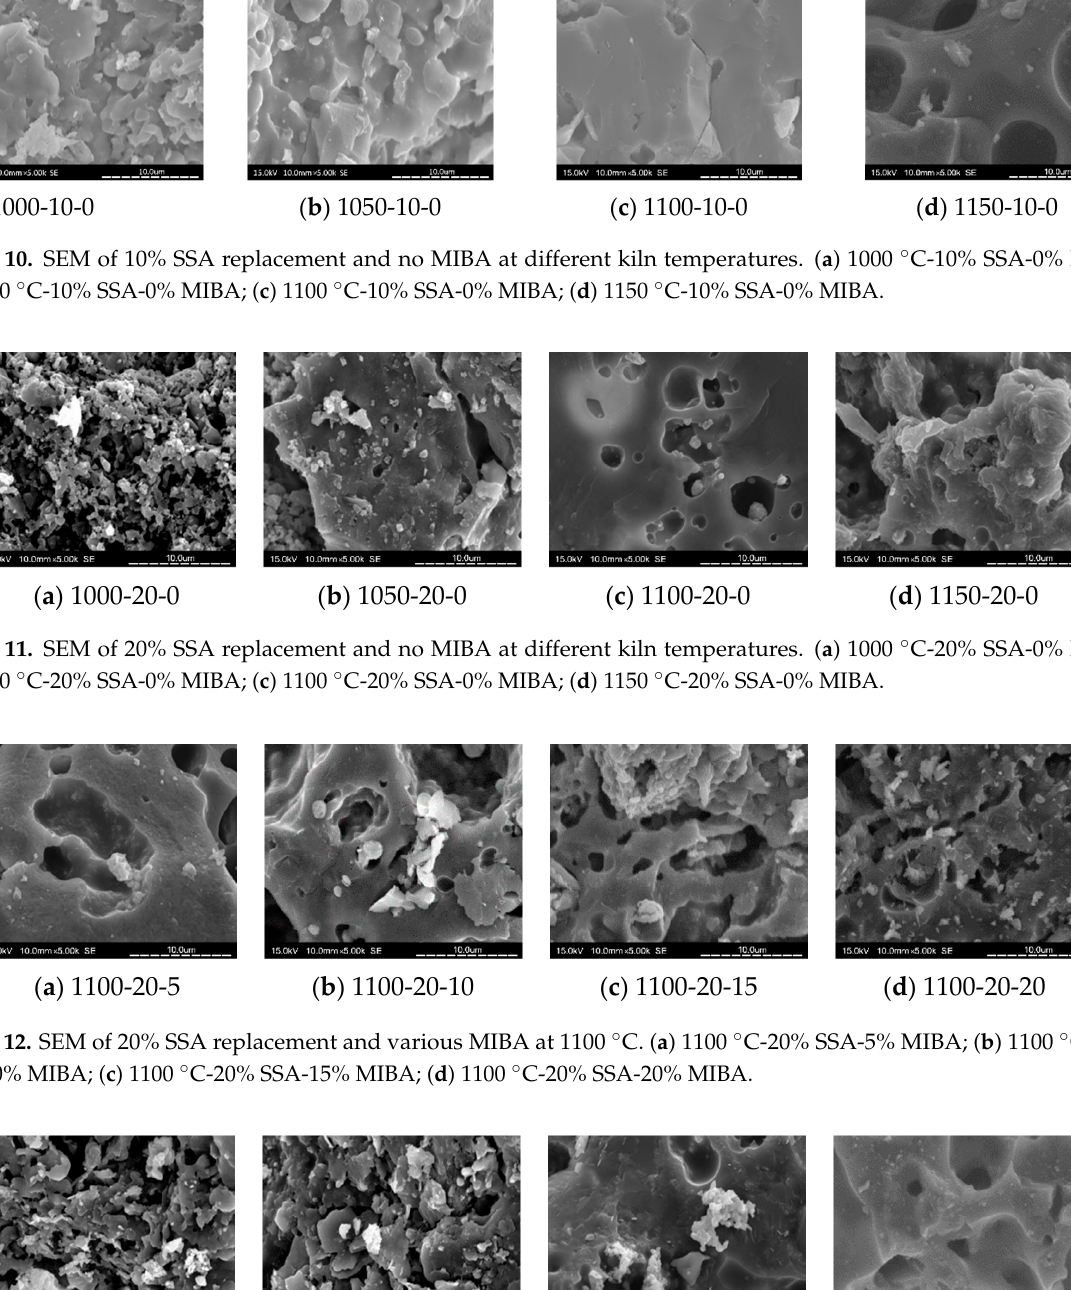
Figure 13. SEM of 10% SSA and 20% MIBA replacement at different kiln temperatures. ( a ) 1000 °C ‐ 10% SSA ‐ 20% MIBA; ( b ) 1050 °C ‐ 10% SSA ‐ 20% MIBA ; ( c ) 1100 °C ‐ 10% SSA ‐ 20% MIBA ; ( d ) 1150 °C ‐ 10% SSA ‐ 20% MIBA .